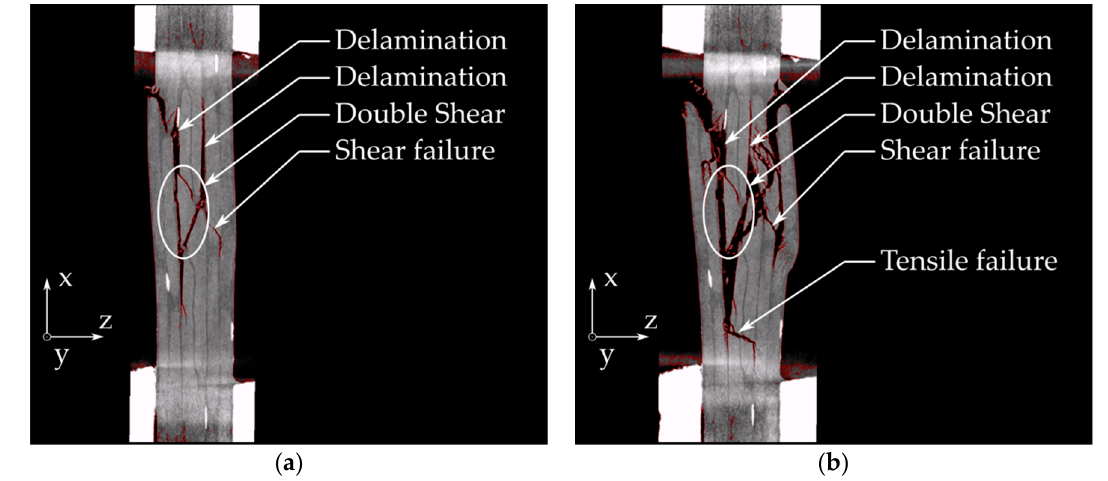
Figure 4. Cross-section visualization of specimen 2 at − 0.5 mm in y-direction: ( a ) point 4, double shear failure in layers 3 and 4; ( b ) point 5, tensile failure in layers 3 and 4. The last measurement, point 5, was stopped after a displacement of 2 mm. Failure